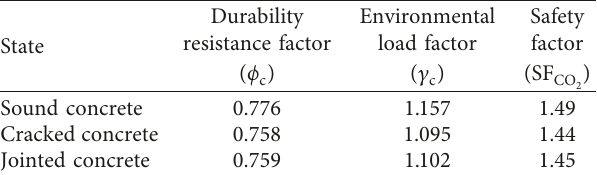
Figure 13: Safety factors calculated for precast and cast-in-place concrete members. Table 3: Safety factors for carbonation depending on different states of cover